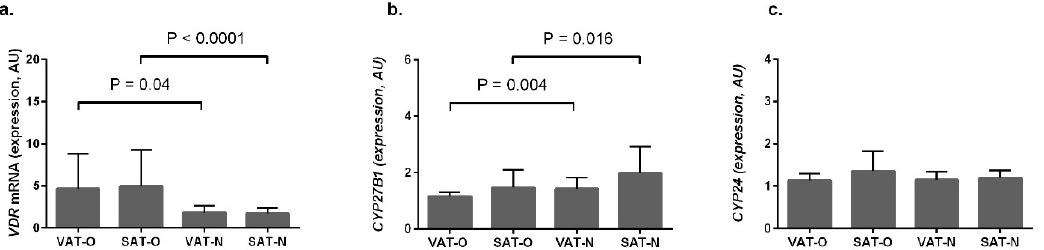
Figure 2. Vitamin D receptor ( VDR ) ( a ) CYP27B1 ( b ) and CYP24A1 ( c ) mRNA levels in visceral (VAT) and subcutaneous (SAT) adipose tissue samples from the obese (O) and normal-weight (N) individuals. Results, normalized against the expression of the β-actin gene ( ACTB ), are presented in arbitrary units (AU) as mean mRNA levels.